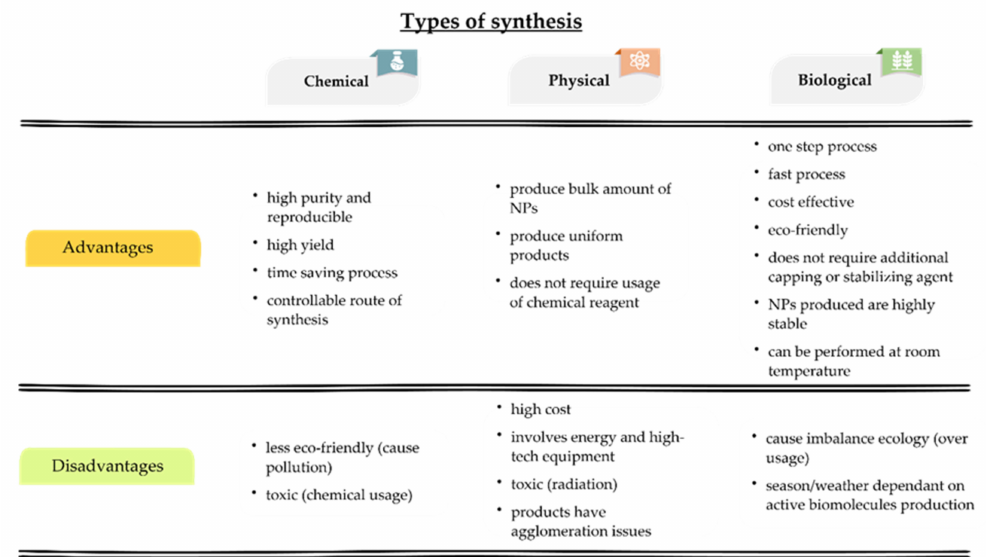
Figure 4. The advantages and disadvantages of three types of synthesis (adapted from Mukherjee and Patra, [38], Sim õ es et al. [39] and Xu et al.